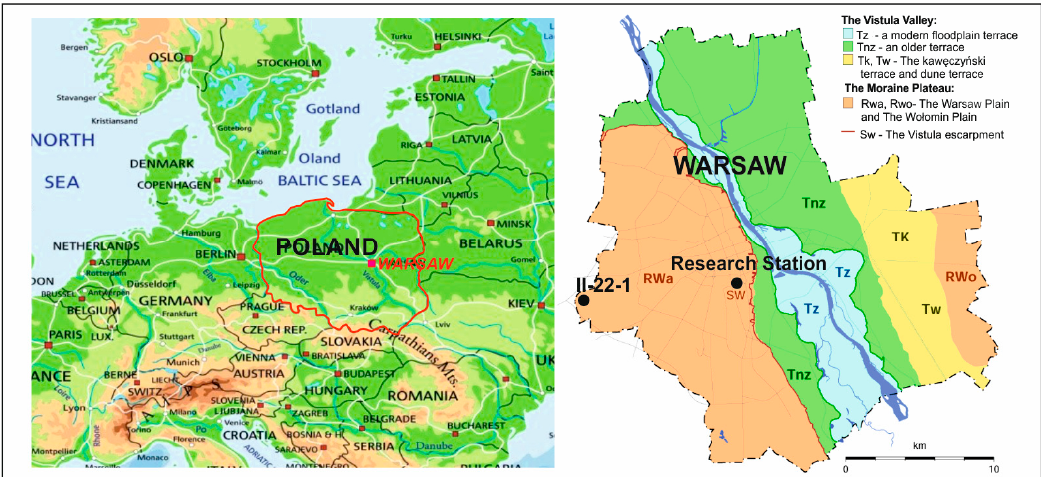
Figure 1. Location of the study area.